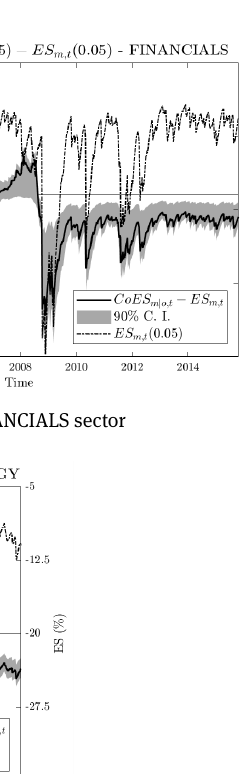
Figure 18c: CoES m | o , t (0.05, 0.05) for a certain sector given a bearish scenario for oil prices